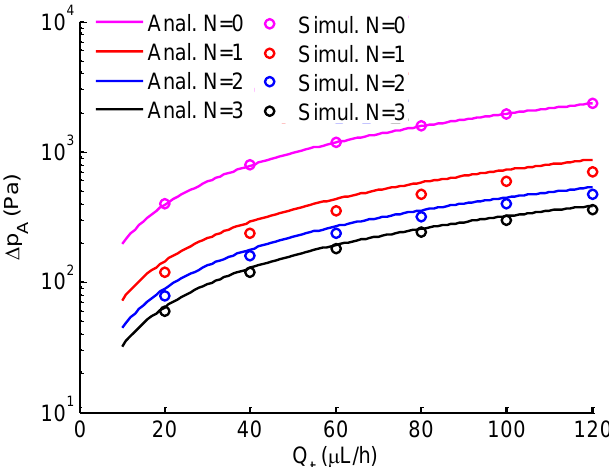
Figure 5. Comparison between analytical (solid lines) and simulation (circle markers) results of the pressure difference across the micropipette aspiration channel versus the total flow rate. N is the number of open aspiration channels.